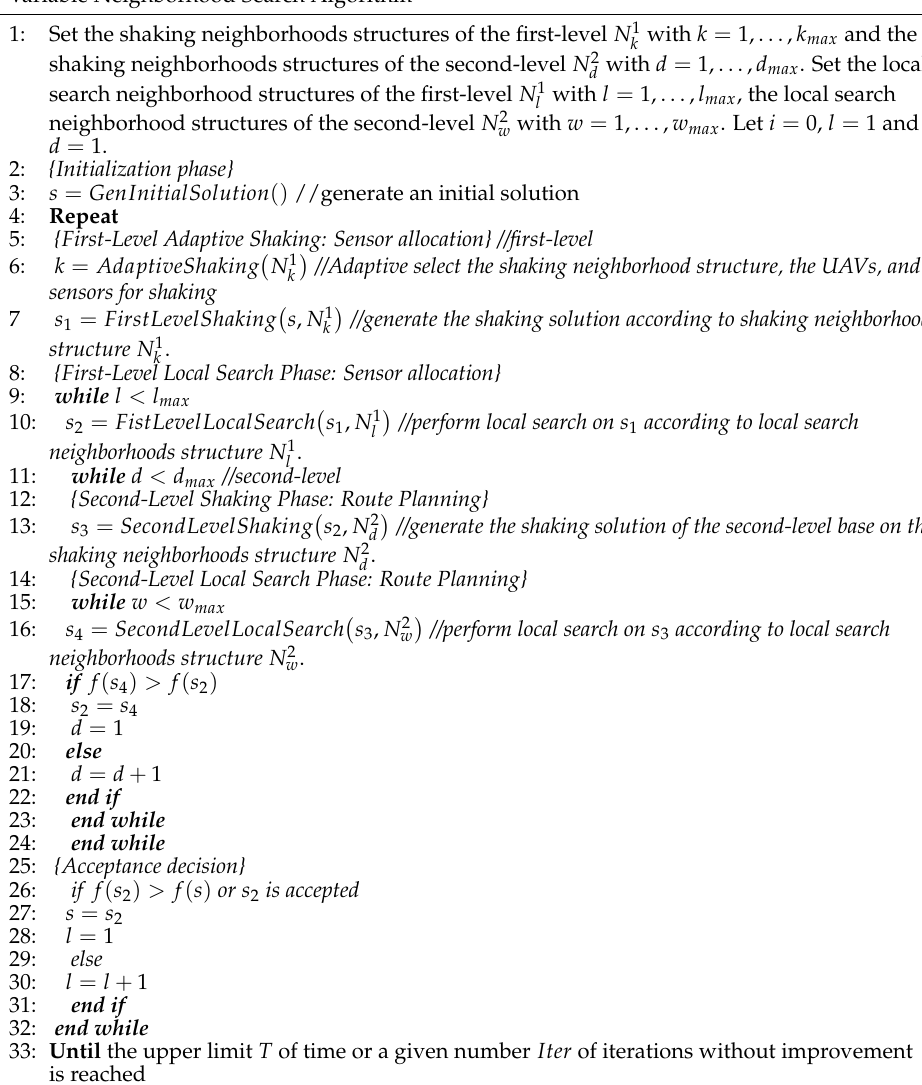
Algorithm 2. The Structure of the Mission Planning Framework Based on the Adaptive Two-Level Variable Neighborhood Search